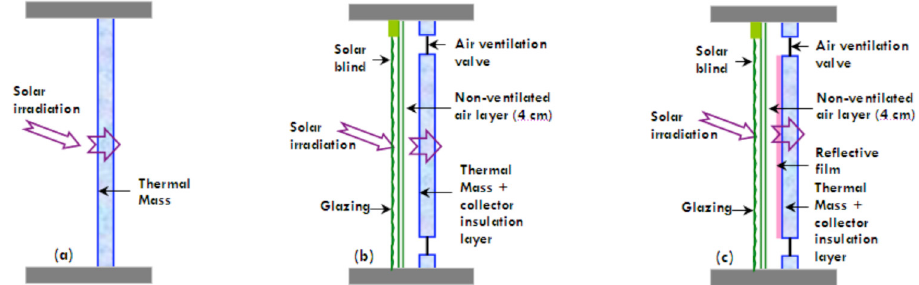
Fig. 3. Trombe wall in overheating periods: (a) ordinary wall; (b) thermal insulation mechanism e = 0.9; (c) thermal insulation with re fl ective fi lm e